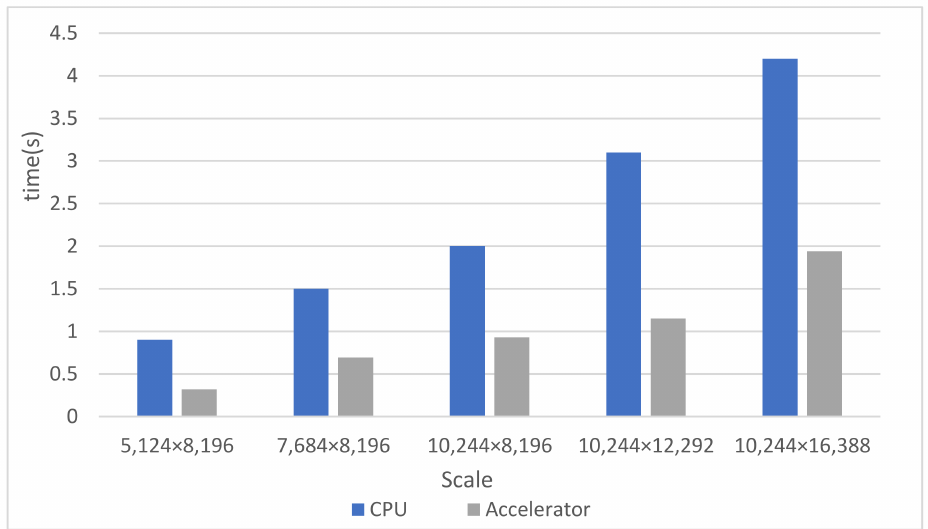
Figure 15. Single CPU vs. single accelerator comparison